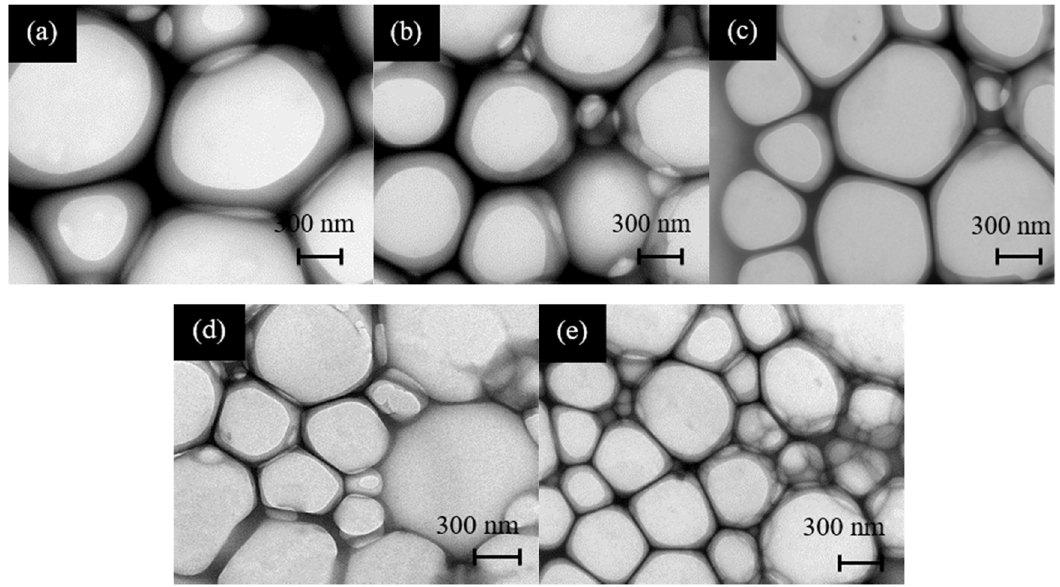
Figure 10: TEM photographs of BSA/AM microcapsules at di ff erent ultrasound times: ( a ) 3 min, ( b ) 4 min, ( c ) 5 min, ( d ) 6 min, and ( e ) 7